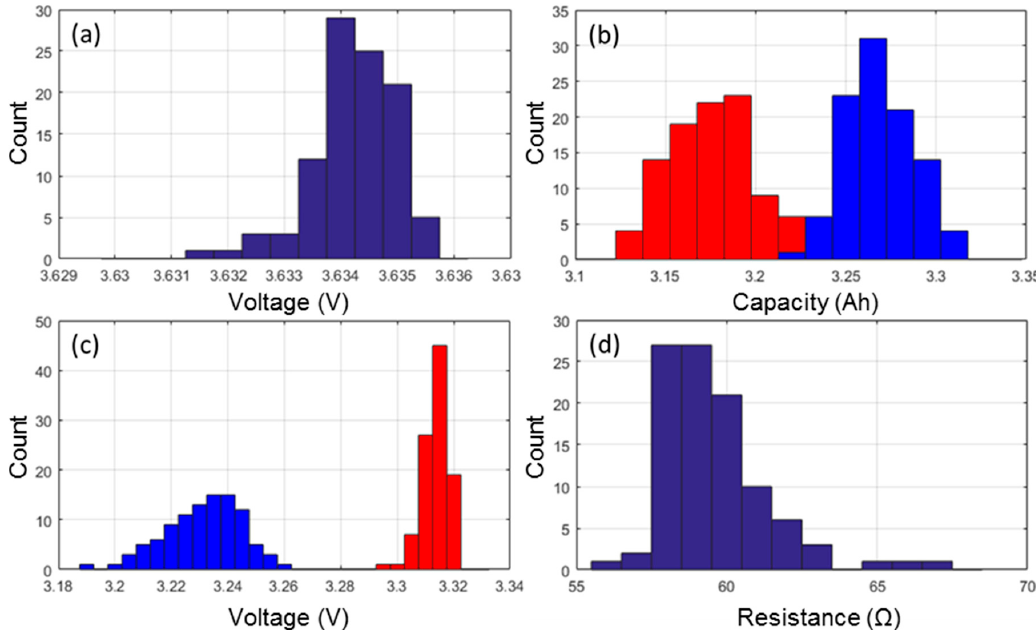
Figure 1. Distribution of ( a ) the as-received open circuit voltages ( OCV ); ( b ) capacity measured at C/5 (blue) and C/2 (red); ( c ) the associated rest cell voltages (RCV) with the same color code; and ( d ) the cell resistances.